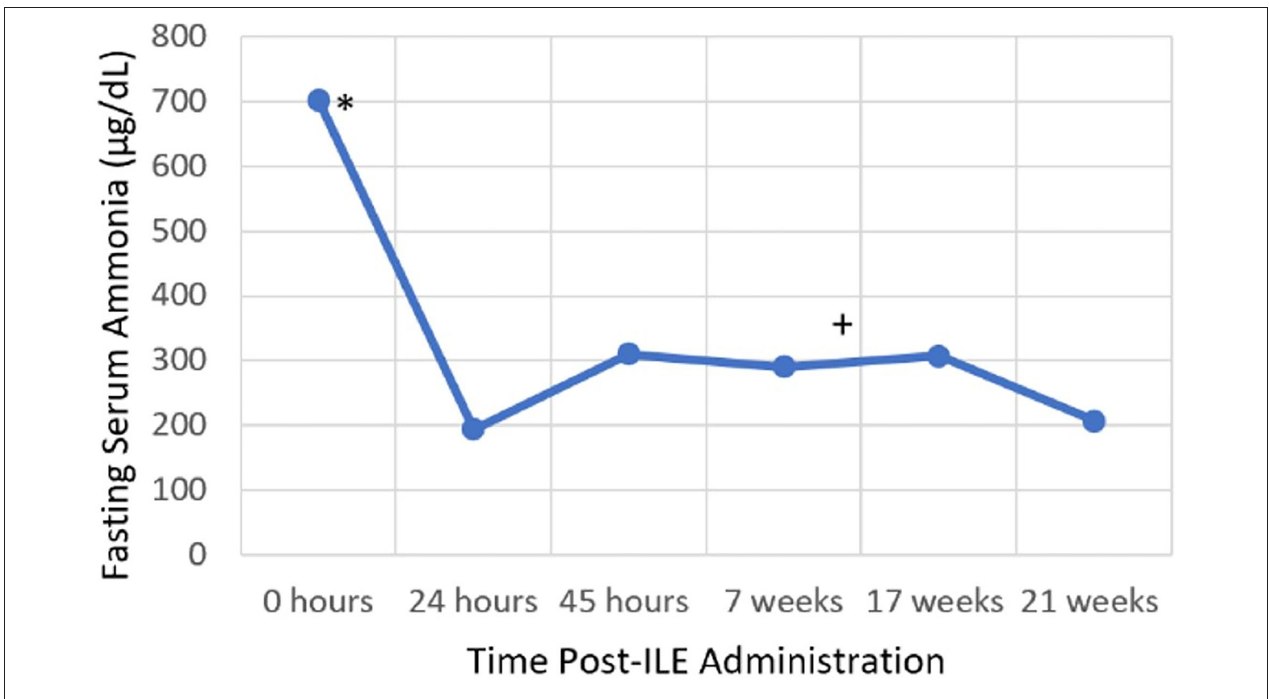
FIGURE 2 | Serial blood ammonia concentration. *Intravenous lipid emulsion administration, + Endovascular coil